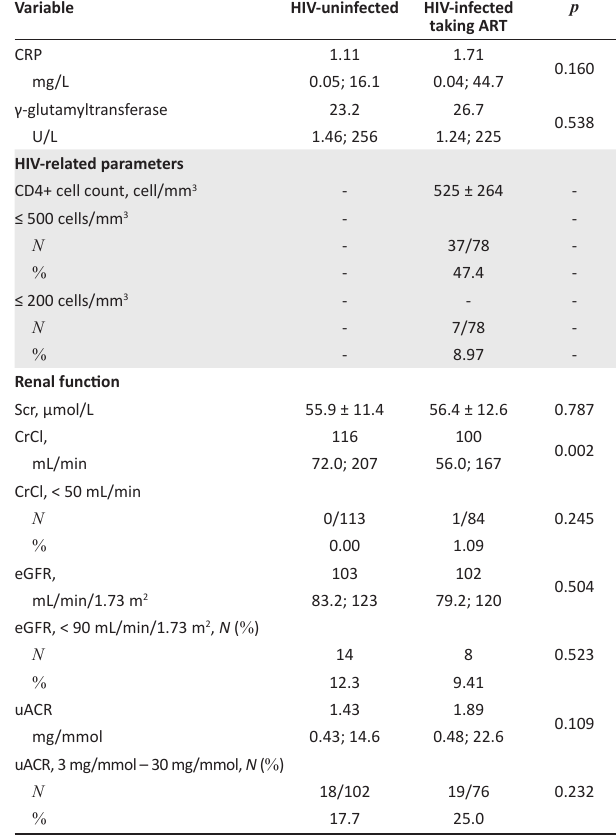
TABLE 2-A1: Characteristics of the HIV-uninfected and HIV-infected individuals taking antiretroviral therapy. Variable